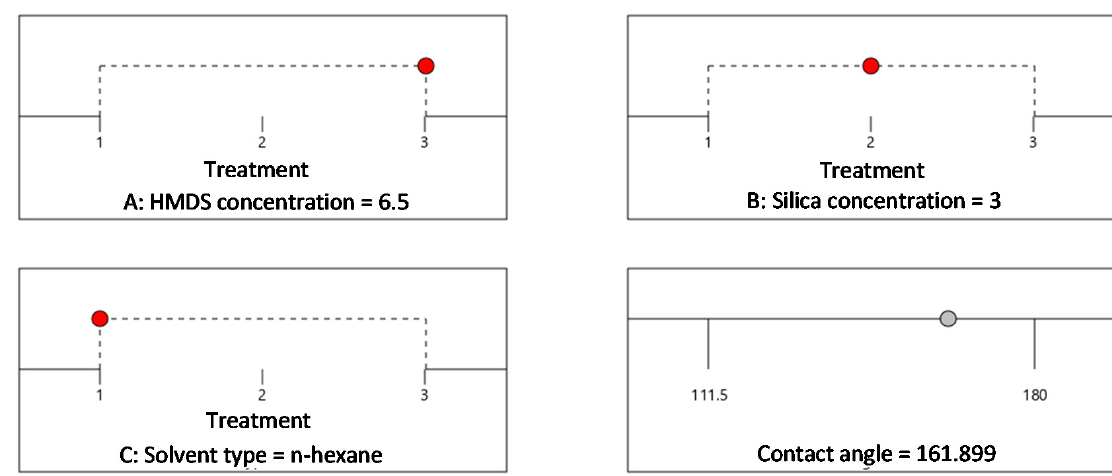
Figure 7. Optimization of the operating conditions of superhydrophobic coating using HMDS.